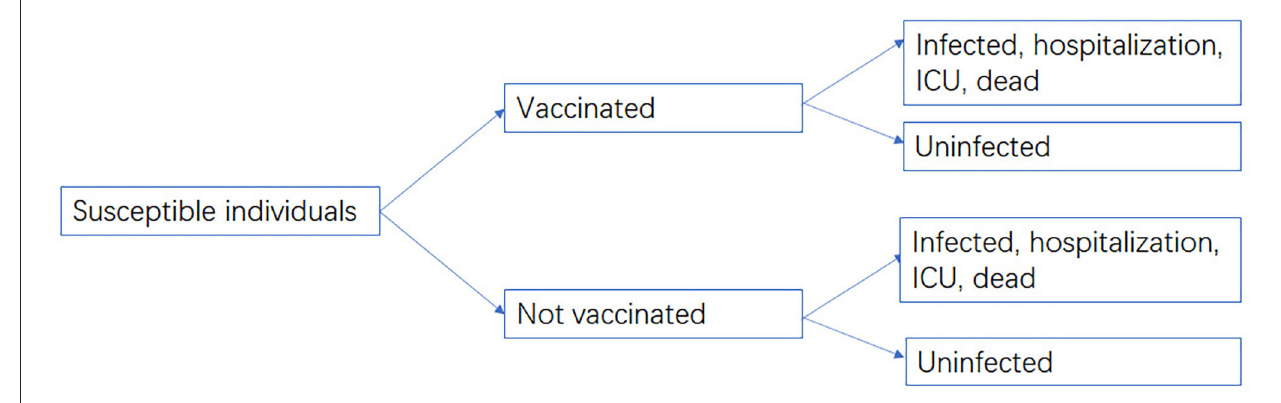
FIGURE 1 | Decision-analytic